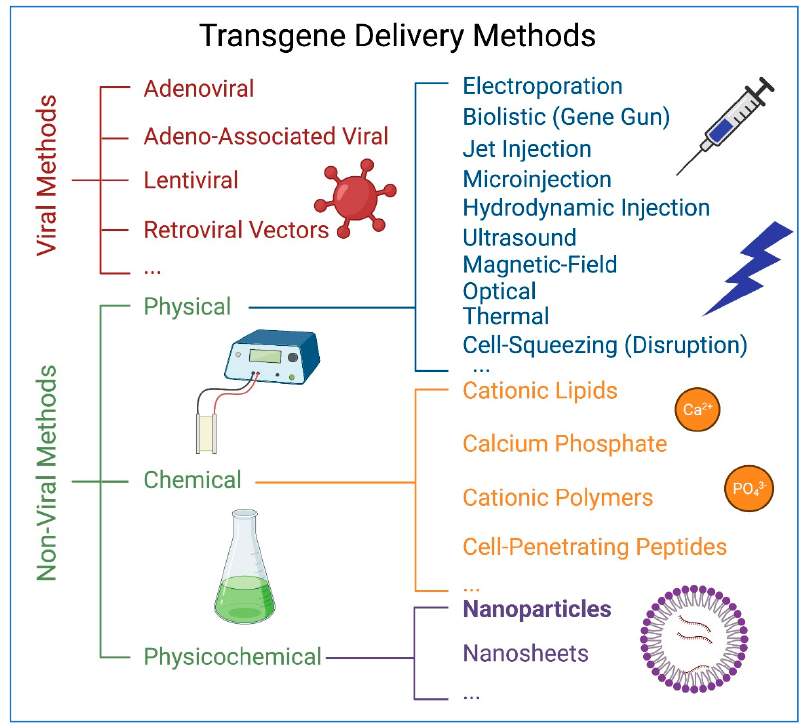
Figure 1. The summary and category of transgene delivery methods. Figure generated using BioRender.